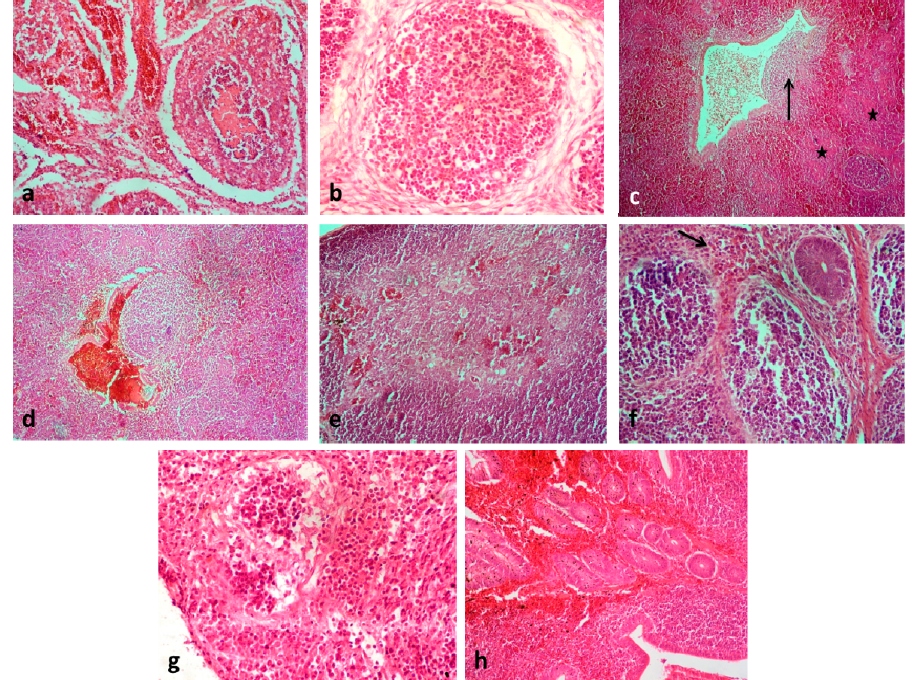
Figure 2. Histopathological lesions in lymphoid organs of di ff erent groups. ( a ) Bursa of NWG with depletion of lymphocytes, cystic cavities in the medulla, extensive hemorrhages and disruption of bursal architecture at 5 dpi H&EX200. ( b ) Bursa of NAG showing rounding of follicles, depletion of lymphocytes and increased macrophages and fibroplasia at 5 dpi H&EX400. ( c ) The spleen of NWG showing areas of necrosis (*) and mild depletion of lymphoid cells around the trabecular vein ( → ) at 2 dpi and ( d ) hemorrhages at 5 dpi H&EX100. ( e ) Hemorrhages in the thymus of NWG at 1 dpi H&EX200. ( f ) Caecal tonsils showing depletion of lymphocytes and infiltration of heterophils ( → ) in NWG at 1 dpi. ( g ) Caecal tonsils showing severe depletion of lymphocytes and an increase in macrophages ( → ) in NWG at 3 dpi. H&EX400. ( h ) Hemorrhages in caecal tonsils of NAG at 3 dpi